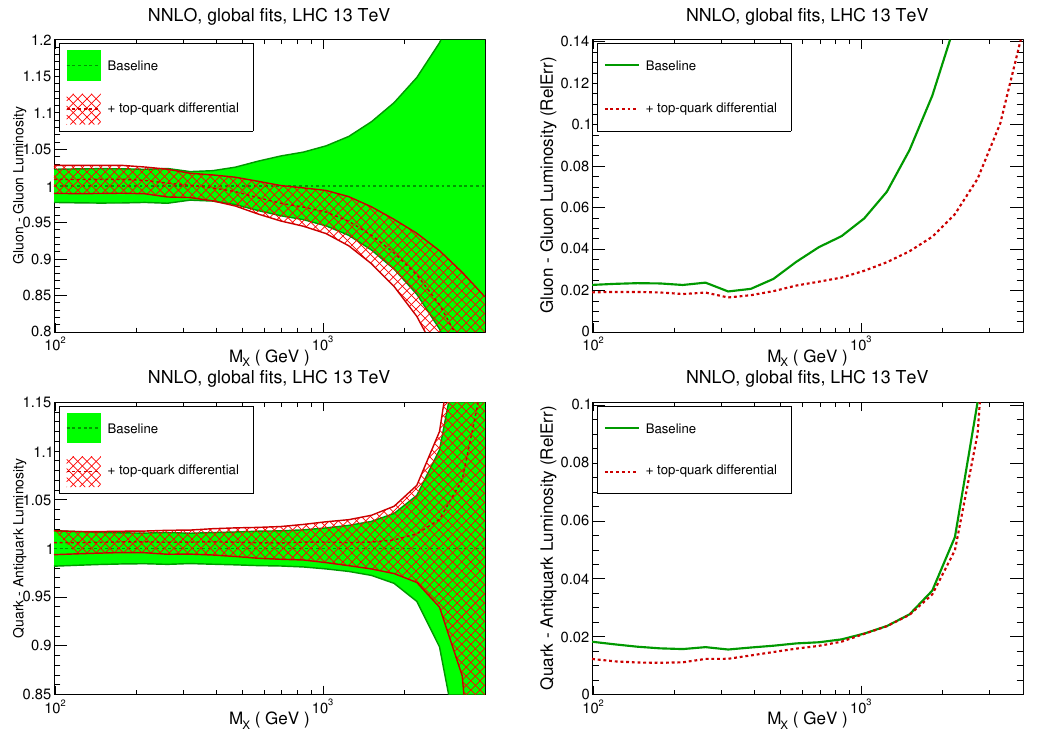
Figure 18 . The gluon-gluon (upper) and quark-antiquark (lower) NNLO luminosities (left) and their relative 1- (cid:27) PDF uncertainties (right) at the LHC with baseline (cid:12)t with the (cid:12)t including the optimal combination of LHC top-quark pair di(cid:11)erential data.